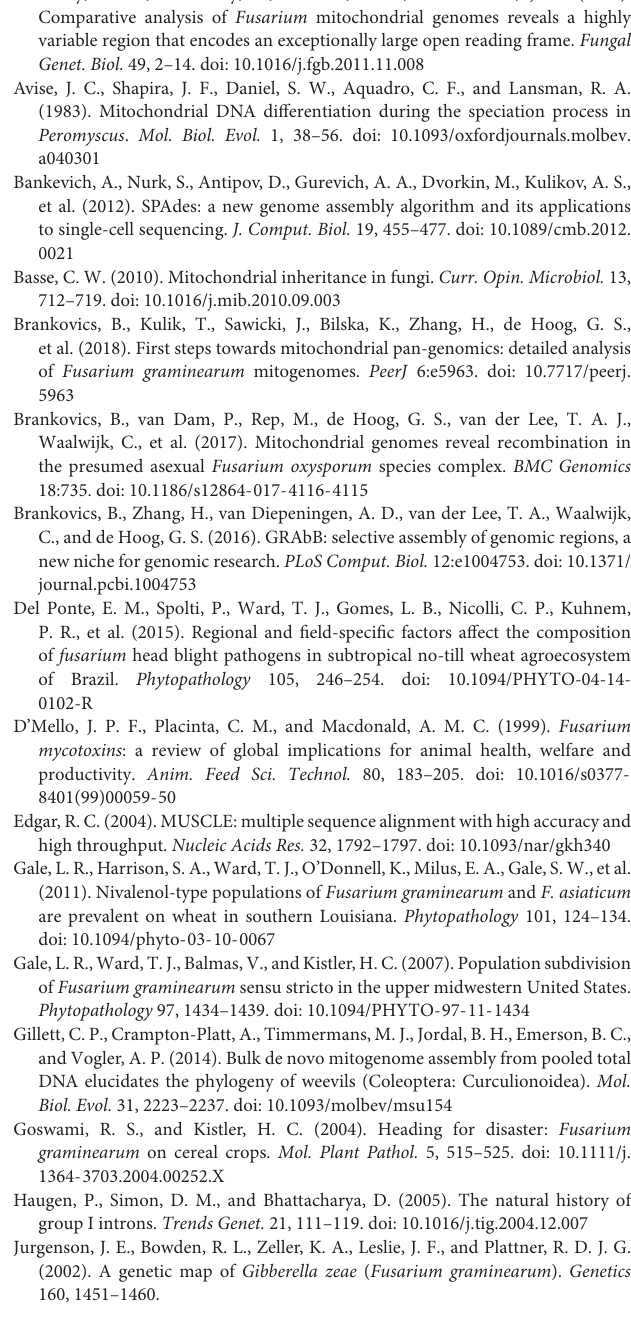
TABLE S1 | Strains information in this study. TABLE S2 | Positions and types of non-synonymous substitutions occurred in the LV-uORF caused by SNPs. TABLE S3 | Intron locations and lengths within standard mitochondrial genes of Fusarium asiaticum and F. graminearum